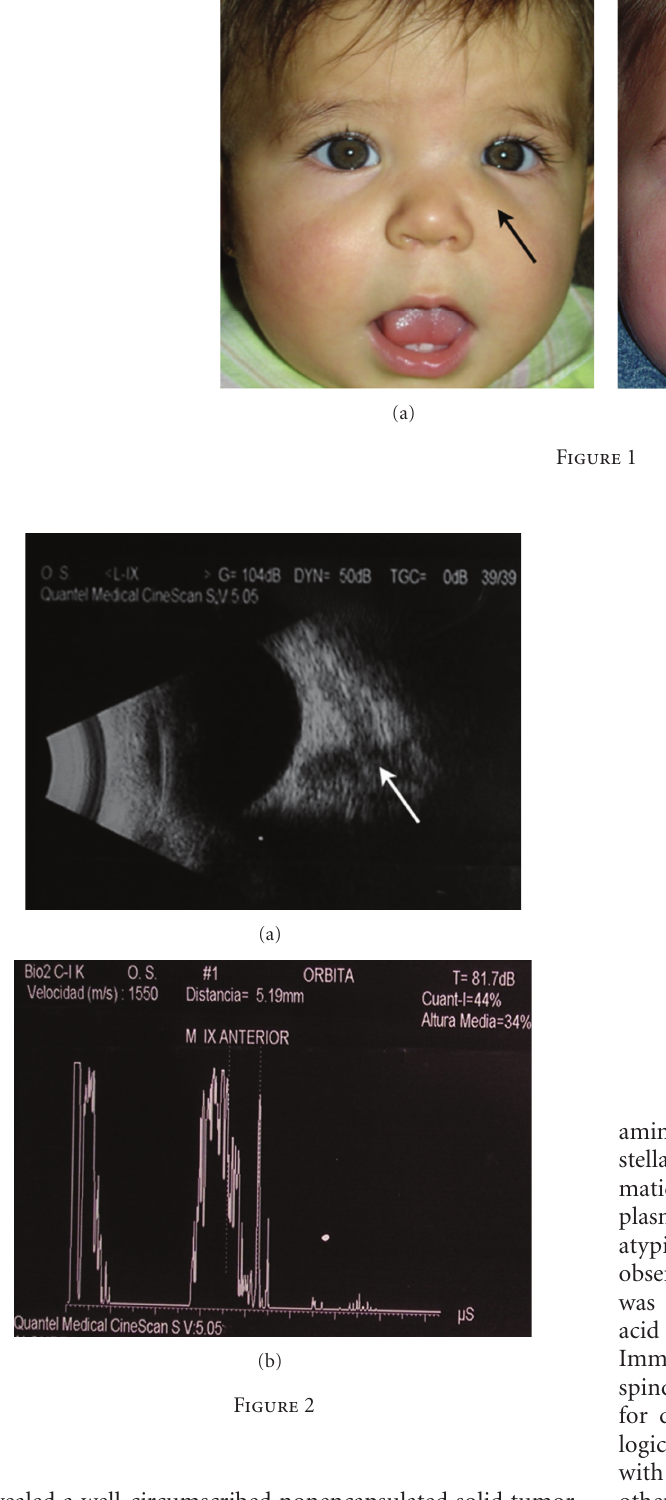
revealed a well-circumscribed nonencapsulated solid tumor measuring 26 mm on its largest diameter. The tumor was soft in consistency. The cut surface had a glistening gray-yellowish appearance (Figure 4). Histopathological ex-